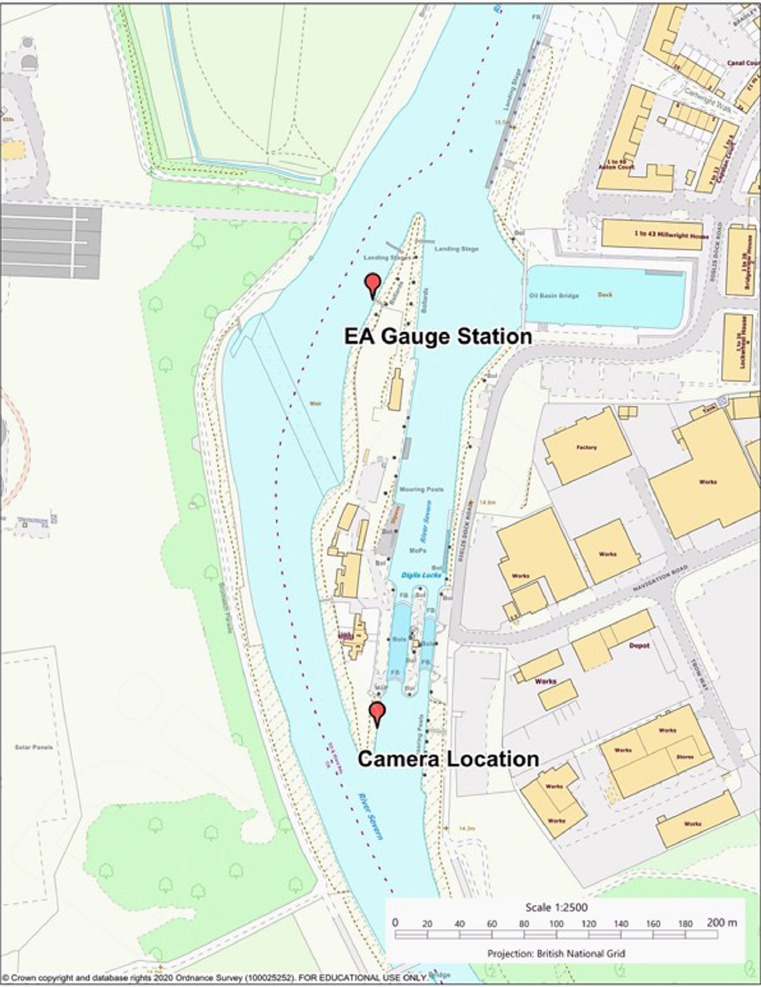
Map illustrating Diglis Lock river camera on river Severn and nearest EA river gauge 'Diglis' (labelled red teardrop shape markers). The map projection is British National Grid and the map scale is given in the bottom right. The vertical is aligned with true North. Produced using EDINA Digimap Ordnance Survey Service, Date created: 09/03/2020. (For interpretation of the references to colour in this figure legend, the reader is referred to the web version of this article.)